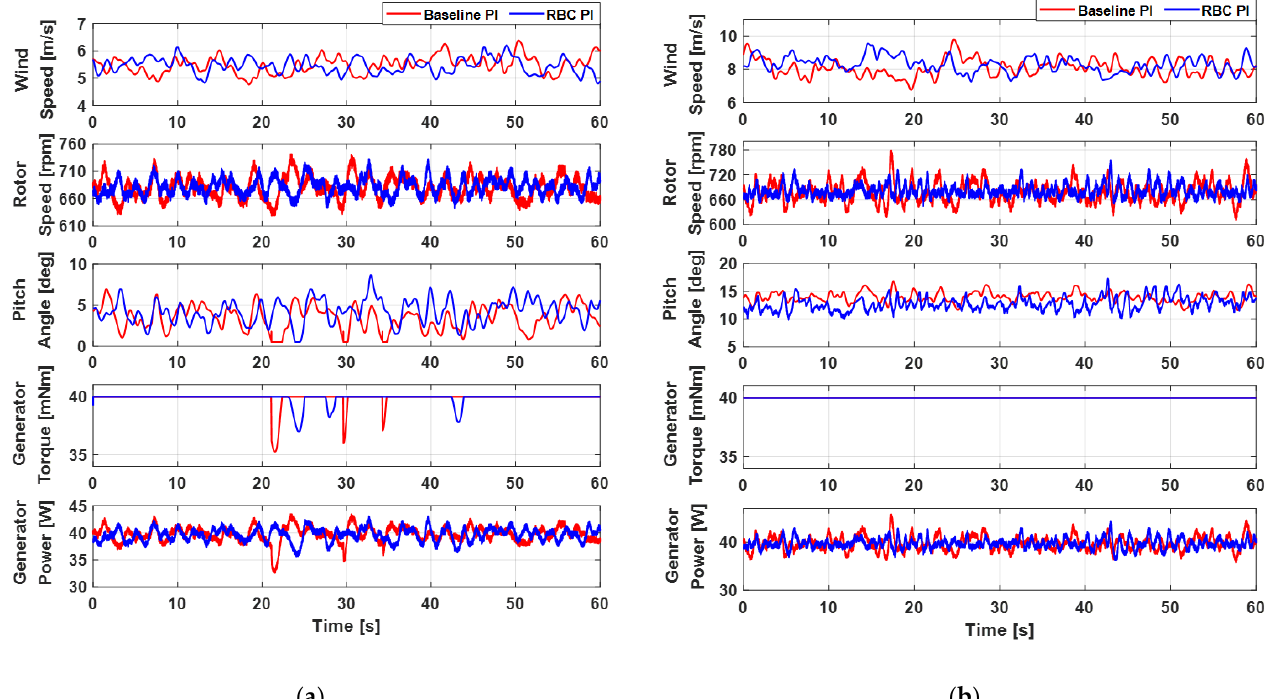
Figure 9. Results from wind tunnel testing of scaled wind turbine model: ( a ) average wind speed of 5.8 m/s and 10% turbulence intensity; ( b ) average wind speed of 8.1 m/s and 10% turbulence intensity.